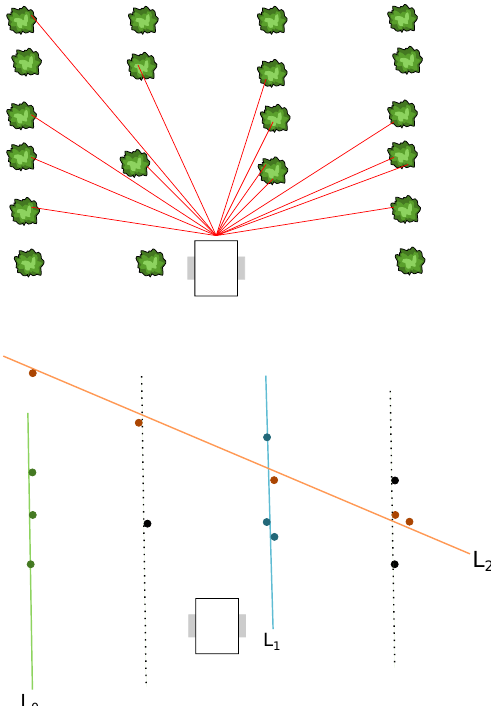
Figure 7. Assuming that from the top configuration, the line finding algorithm returns the models L 0 , L 1 , and L 2 (bottom part of the figure). The expected behavior of the filter is to keep the models L 0 and L 1 (removing the model L 2 ) and knowing the distance d between the rows, to compute the missing models (dotted lines). Note that for the bottom part of the figure, the colors of the dots correspond to the models the points are associated